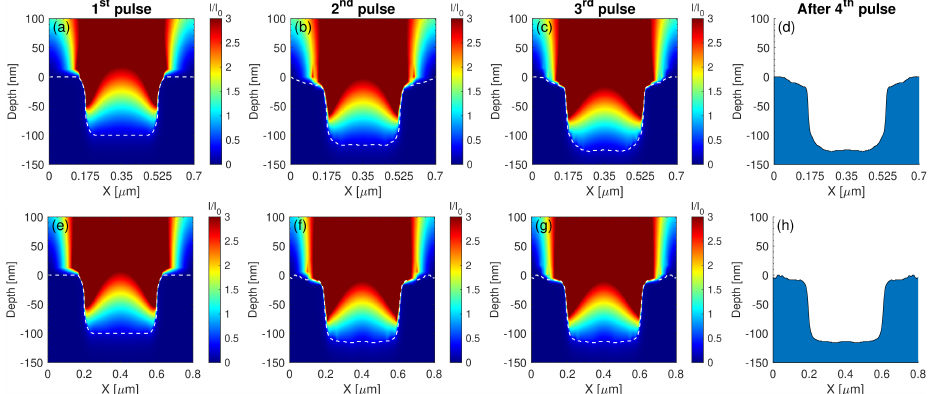
Figure 7. Spatial profile of the intensity distribution for different pre-pattern distances ( a – c ) Λ pre − pattern = 700 nm and ( e – g ) Λ pre − pattern = 800 nm during three successive irradiations with laser pulses of λ = 1026 nm and the corresponding final topographies ( d , h ) after the fourth pulse. The white dashed line indicates the surface